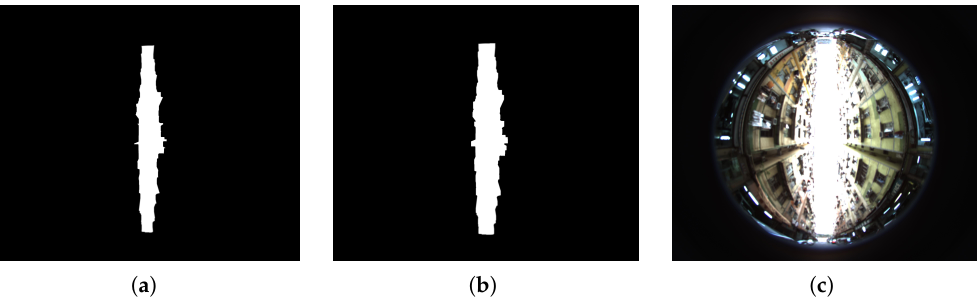
Figure 10. The correct recovery of regions misidentified as part of the sky region through image morphology processing. ( a ) The result of erosion operation. ( b ) The result of dilation operation. ( c ) The original